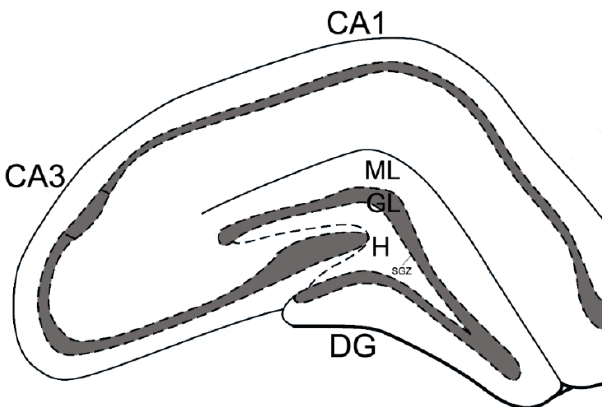
Figure 1. Diagram of the rat hippocampus. Areas of the dentate gyrus (DG): SGZ—subgranular zone, ML—molecular layer of dentate gyrus, GL—granule cell layer, H—hilus of dentate gyrus.